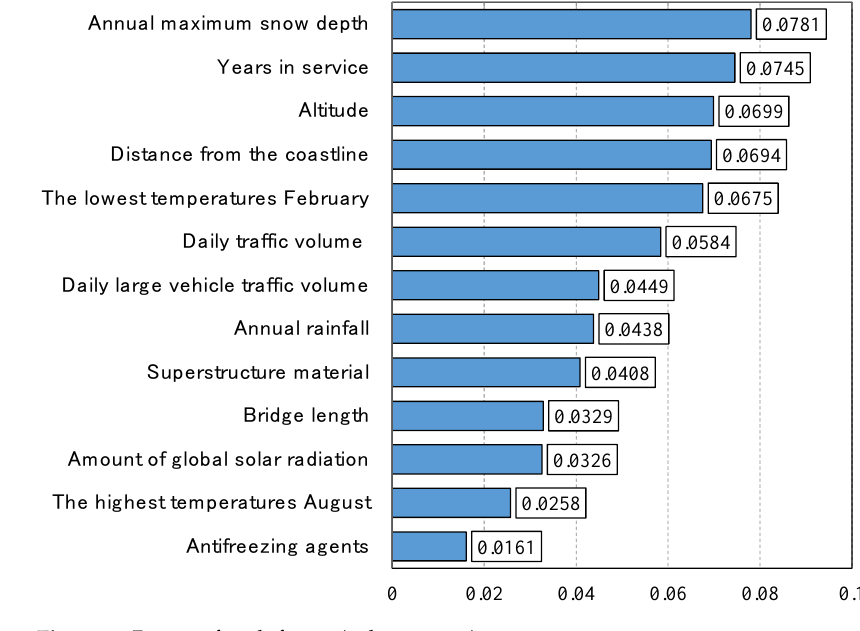
Figure 9. Range of each factor (substructure).